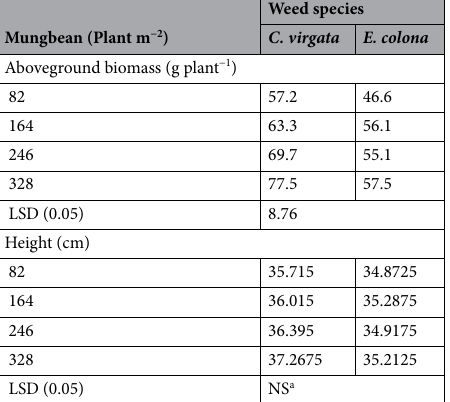
Table 3. Effect of C. virgata and E. colona competition with mungbean on mungbean height and aboveground biomass. a NS: